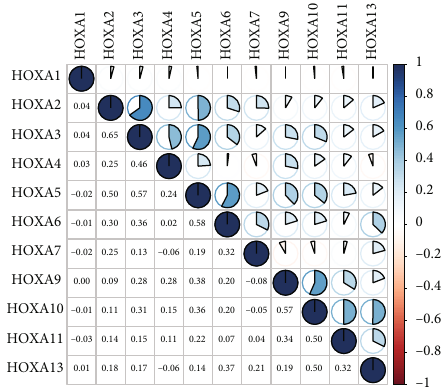
Figure 2: Relationship between HOXA family